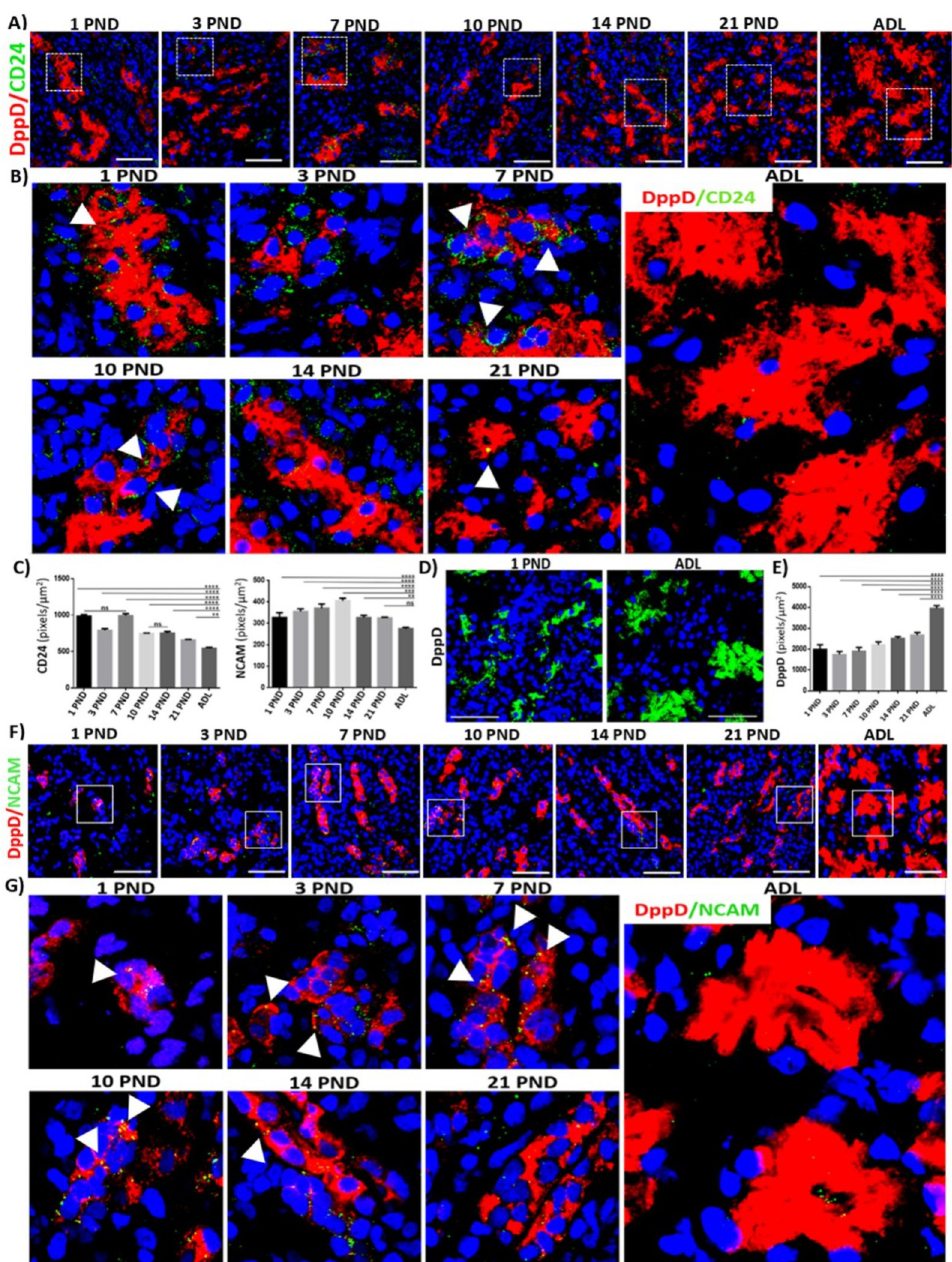
Fig 6. Expression of renal progenitor cell (RPC) markers in the proximal convoluted tubule during postnatal development and in adulthood of the rat. Immunofluorescence analysis of the general expression pattern of two RPC markers, CD24 (A) and NCAM (F) during postnatal renal maturation. B and G) magnification of the boxes in A and F, respectively, there is a higher expression of RPC markers in the proximal convoluted tubules of newborn rats and they decrease significantly in the adult, this is reflected in their semi-quantitative analysis (C). Small areas are observed where RPCs markers colocalize with DppD (arrowhead). We found a significant increase in the expression of DppD when comparing PND 1 with the adult (D, DppD in green), consistent with the semi-quantitative analysis (E). DppD (red A, B, F, G), CD24 (green, A and B) NCAM (green, F and G), Merge (yellow) and nuclei with DAPI (blue) are shown. The white squares represent the magnification of specific areas in the proximal convoluted tubule. Scale bars = 50 μ m. Values are means ± standard deviation (SD). One-way ANOVA. * p < 0.05, **** p < 0.0001. ns = not significant. Immunofluorescence experiments were performed in kidney sections. A representative experiment is shown (n = 3).